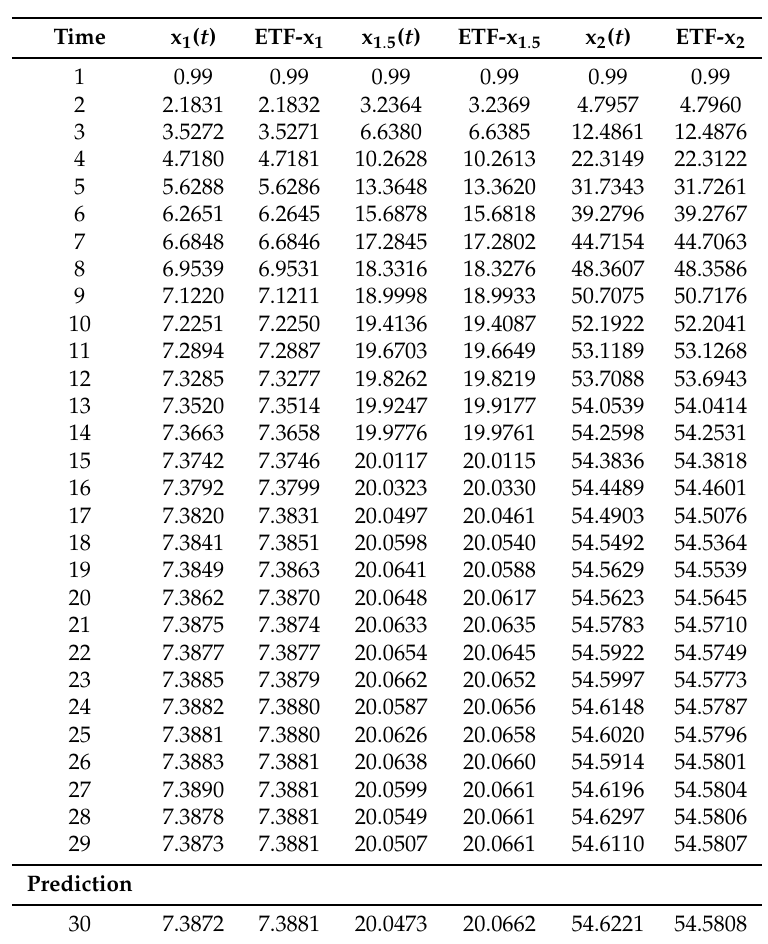
Table 1. Simulated data and estimated trend function.